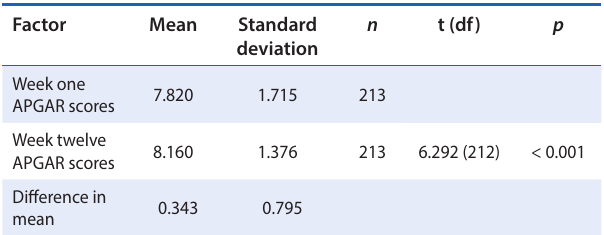
Table 4: Paired t-test comparing weeks 1 and 12 APGAR scores in the study population